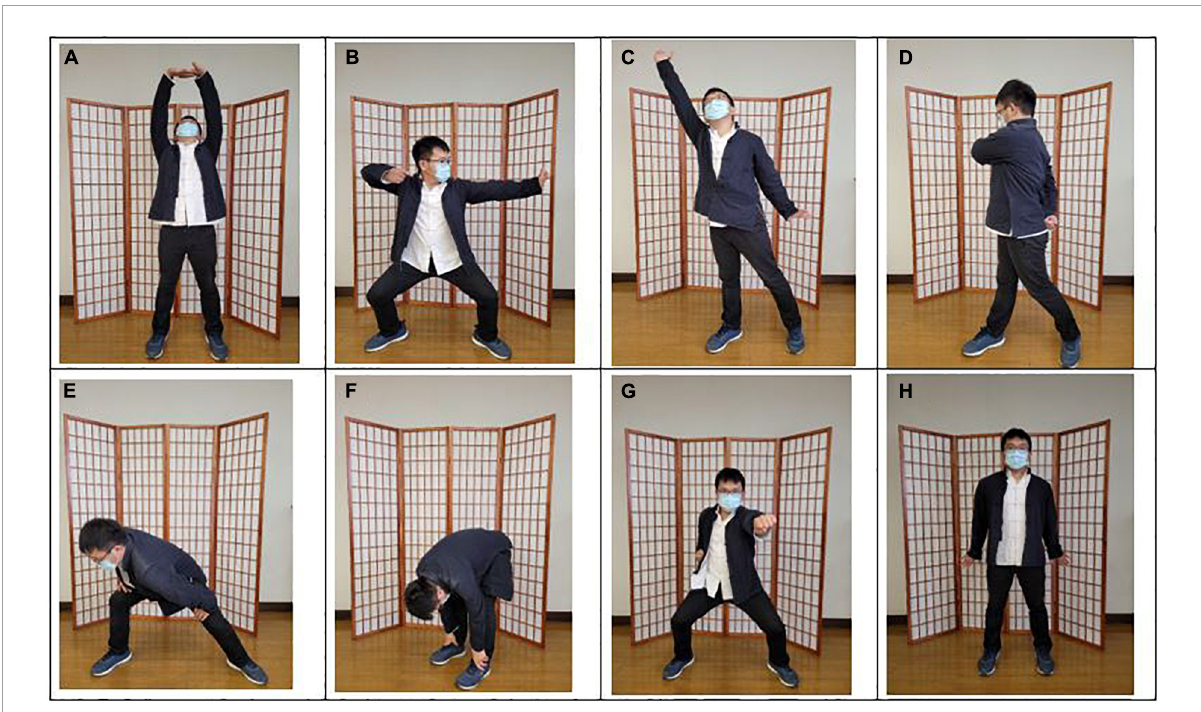
FIGURE2 The postures of Baduanjin exercise. (A) Both hands holding up the heavens; (B) drawing the bow to shoot the eagle; (C) separating the heaven and earth; (D) wise owl gazing backwards; (E) swaying the head and shaking the tail; (F) both hands holding the feet to strengthen the waist; (G) clenching the fists and glaring fiercely; (H) bouncing on the